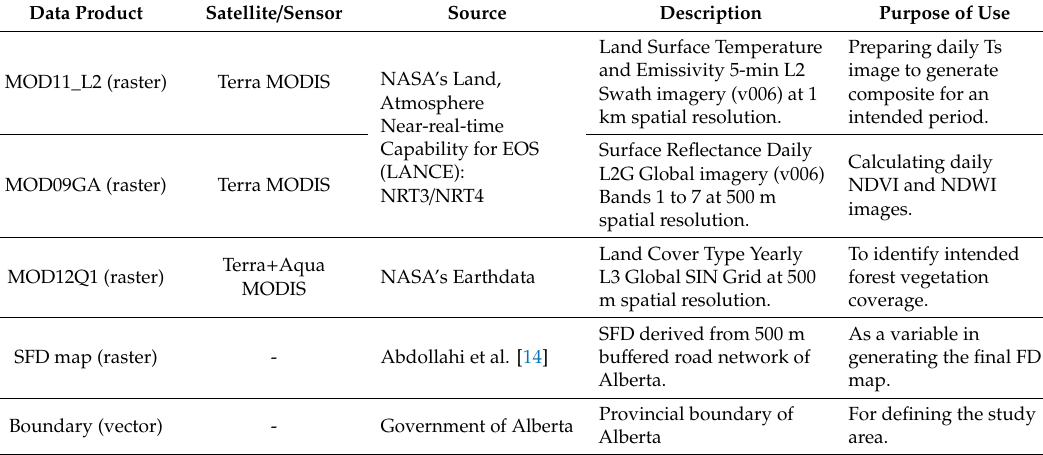
Table 2. Brief description of the datasets used in this